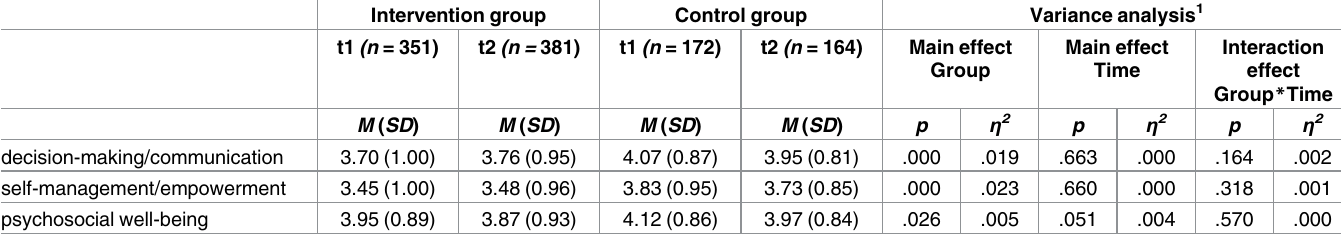
Table 10. Patient survey:Univariate comparisons of CCRQ scales for group and time of data